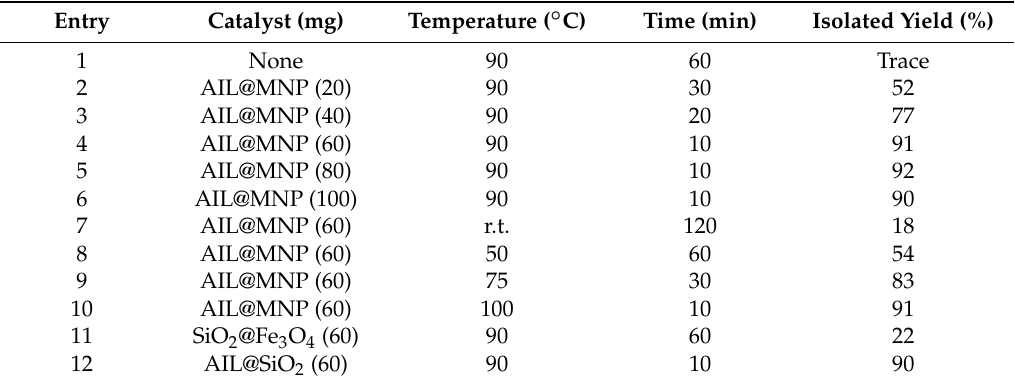
Table 1. Screening conditions for the reaction of benzaldehyde with 2 ‐ naphthol and acetamide.